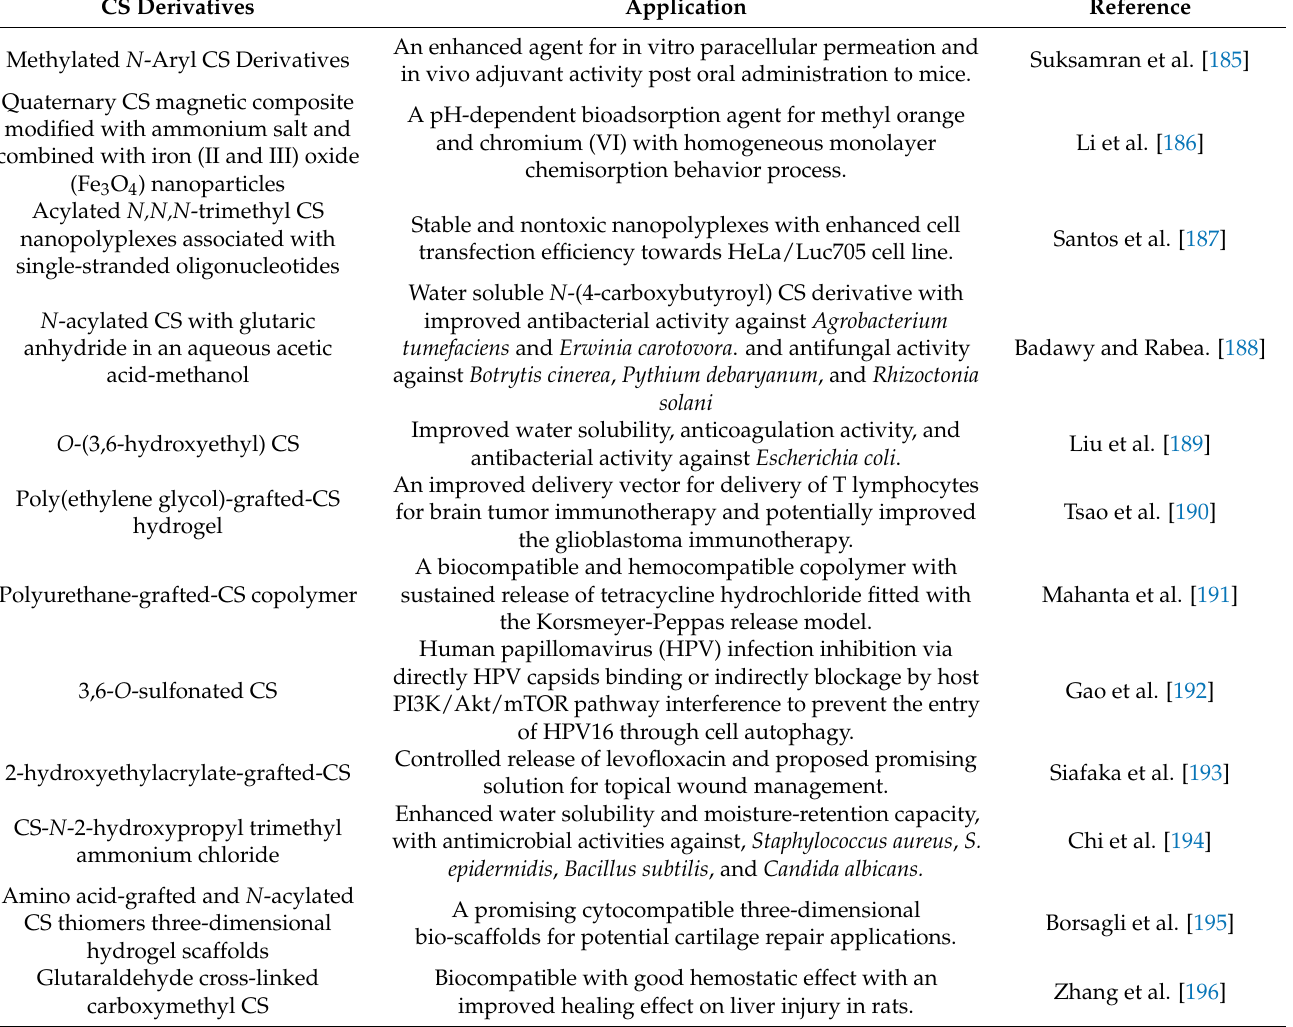
Table 1. Applications of chemically-modified CNP-based